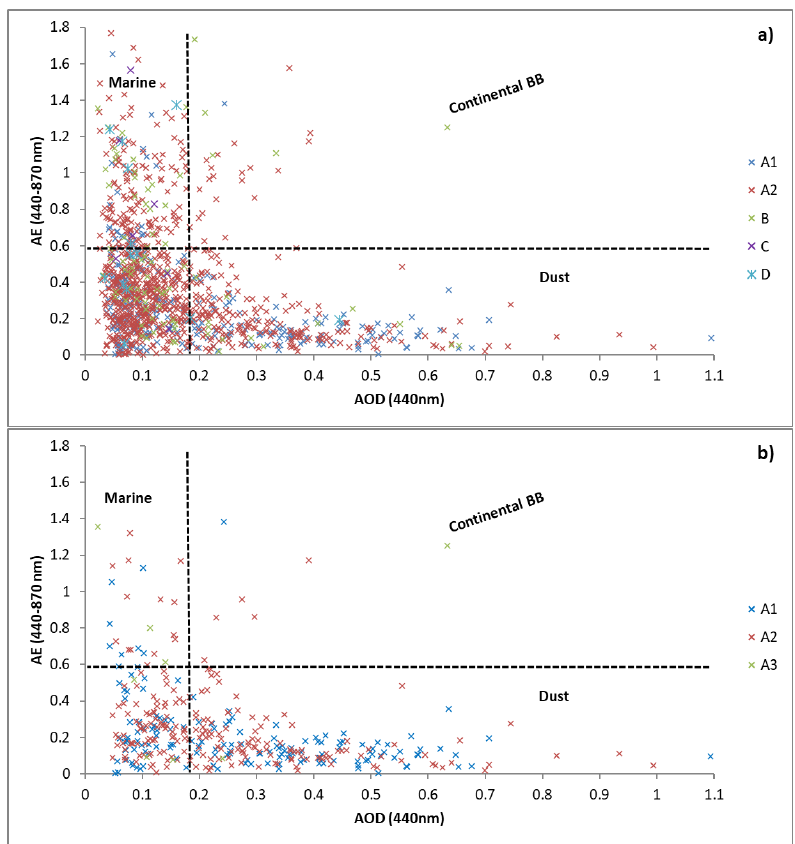
Figure 11. AE (440–870 nm) versus AOD (440 nm) distribution in PR from 2000 to 2020 for ( a ) all cases and ( b ) dusty cases ( [ PM 10 ] ≥ 35 µ g.m − 3 ) according to the following ratios: A1 = PM 2.5/ PM 10 < 0.2, A2 = 0.2 ≤ PM 2.5/ PM 10 < 0.4, B = 0.4 ≤ PM 2.5/ PM 10 < 0.6, C = 0.6 ≤ PM 2.5/ PM 10 < 0.8 and D = PM 2.5/ PM 10 ≥